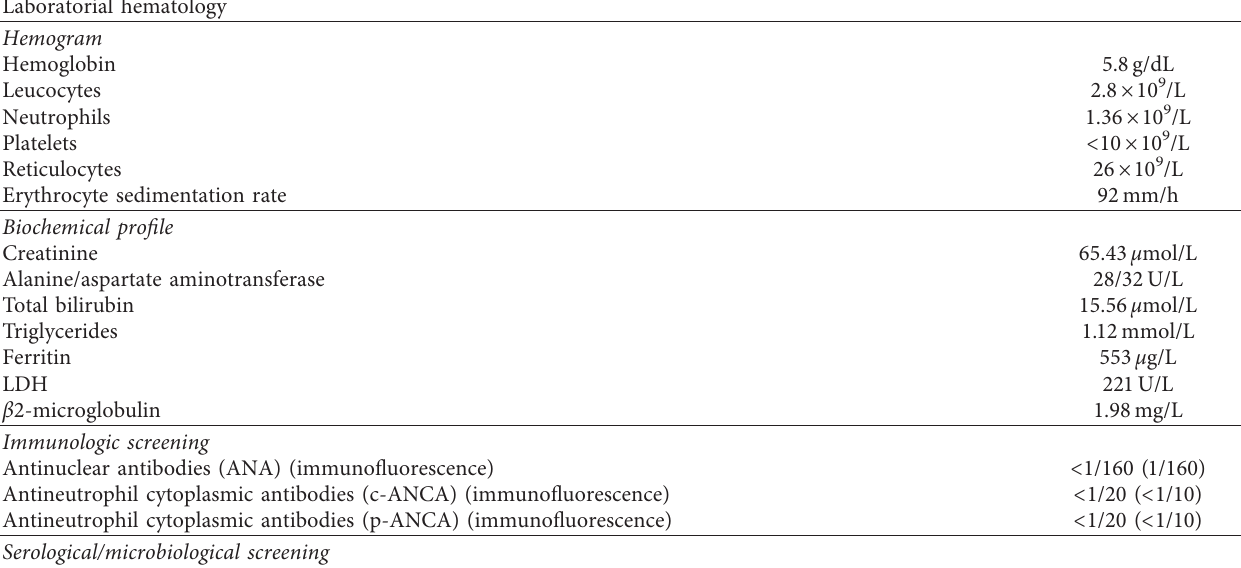
Table 1: Patient’s initial blood